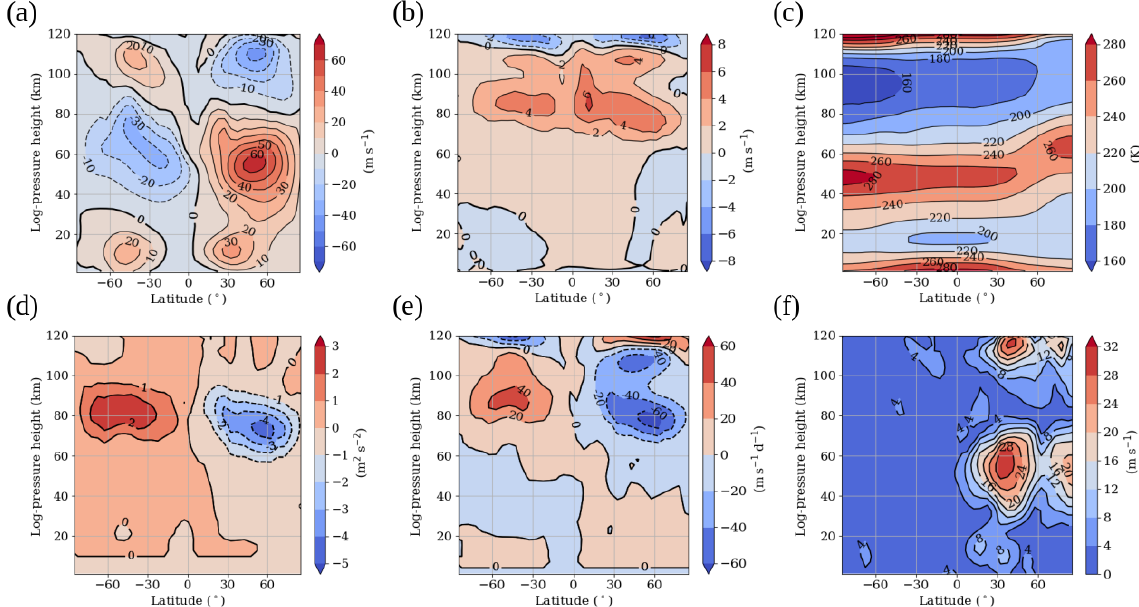
Figure 1. January zonal and monthly mean of the (a) zonal wind (ms − 1 ), (b) meridional wind (ms − 1 ), (c) temperature (K), (d) zonal GW fluxes (m 2 s − 2 ), (e) zonal wind acceleration due to breaking GWs (ms − 1 d − 1 ) and (f) SPW 1 amplitude (ms − 1 ) extracted from the zonal wind of the reference